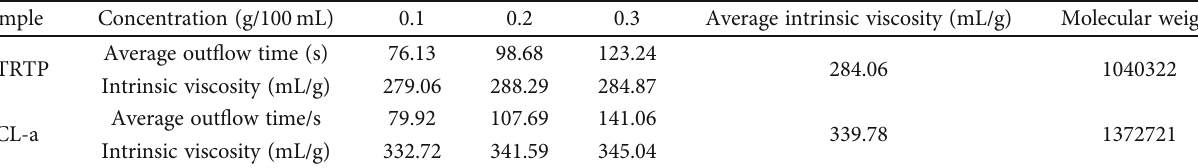
Table 2: Testing results of intrinsic viscosity and molecular weights.